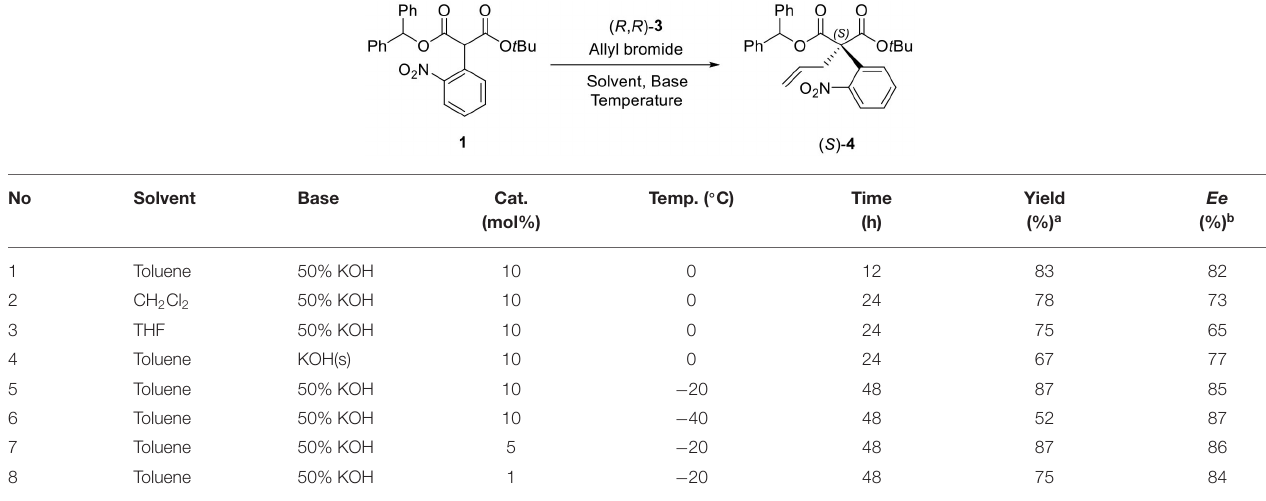
TABLE 1 | Optimization of α -allylation under PTC